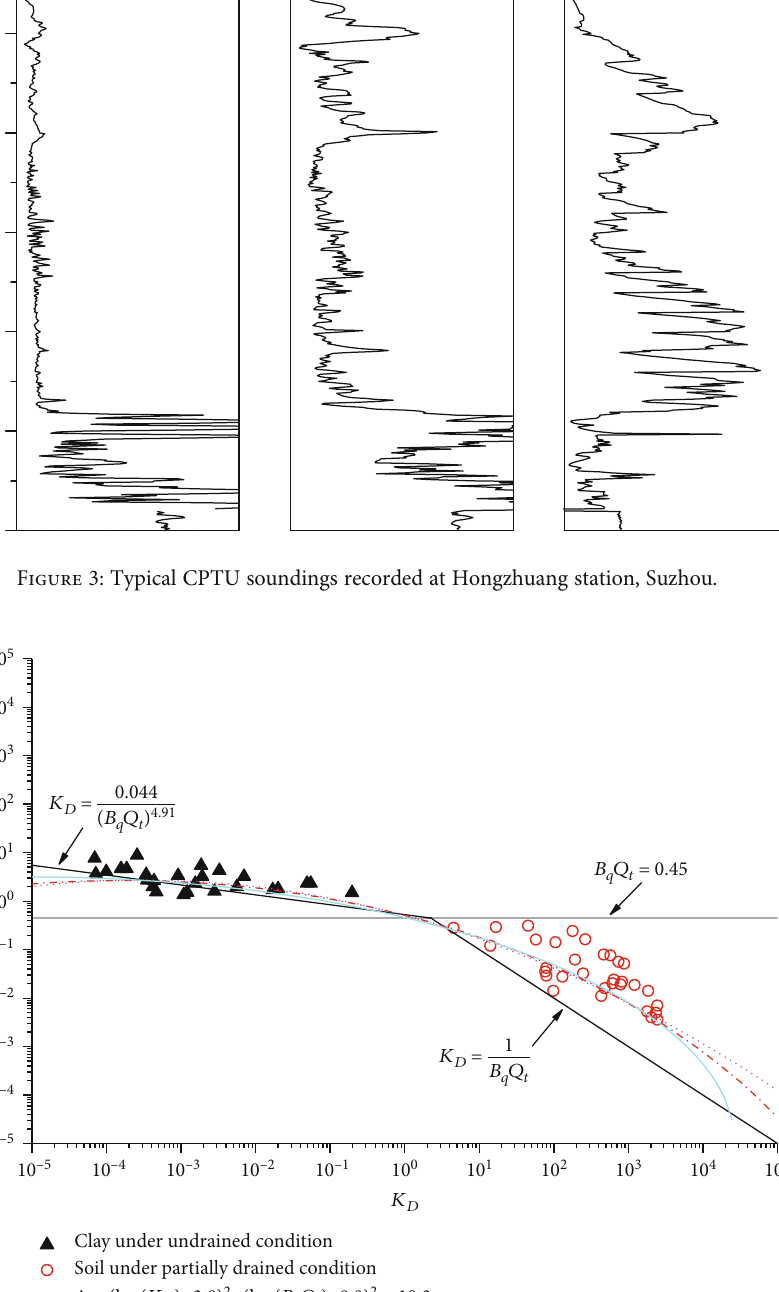
Figure 4: Relationship between measured nondimensional hydraulic conductivity K Figure 2. A summary description of soils in these sites is presented in Table 1. Typical pro fi les of CPTU measure- ments, including cone tip resistance ( q t ), side friction resis-